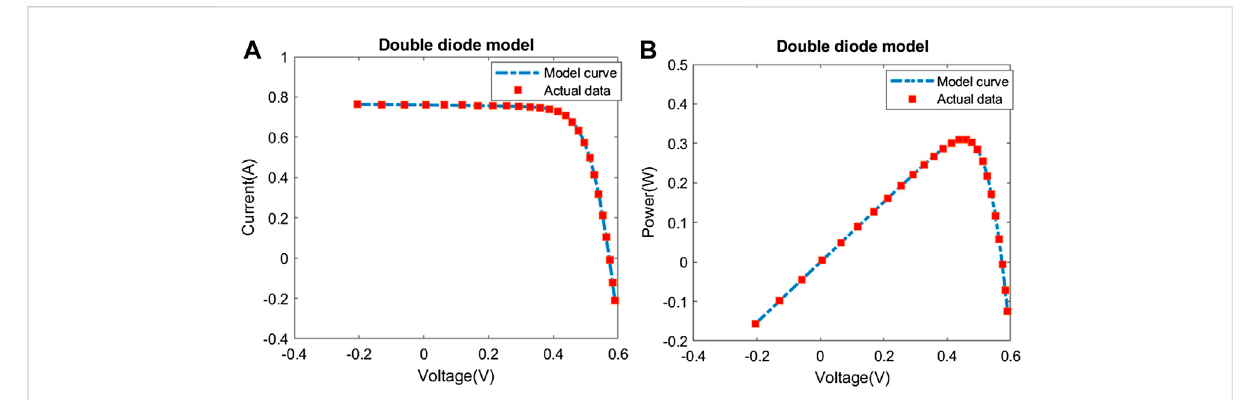
FIGURE 5 Comparison between actual data and model curve obtained by POA for DDM: (A) I-V curve and (B) P-V curve.